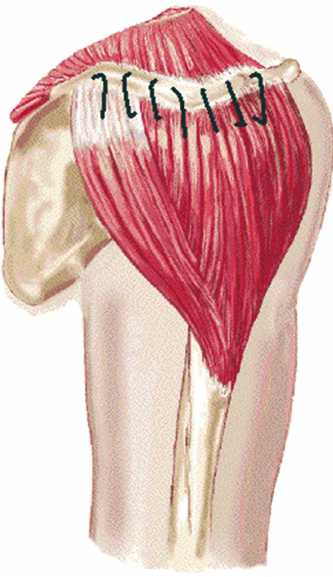
Figure 2: Reattachment of the deltoid muscle to its origin from the acromion and